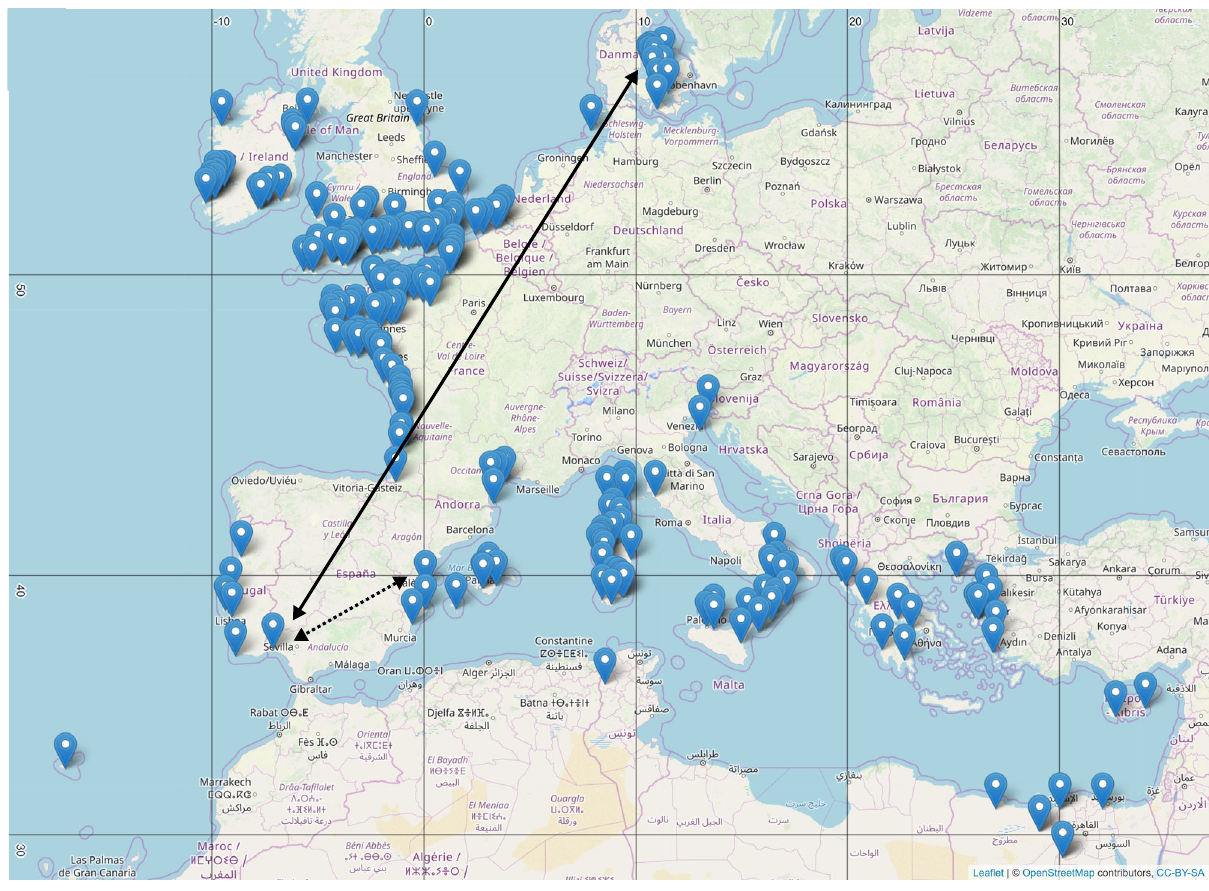
Fig. 4 Location of sequenced wild beet accessions based on sampling coordinates obtained from public passport data. The black arrow points to two accessions separated by large geographical distance that show a small genetic distance. The dotted arrow points to accessions both originating from Spain and showing a larger genetic distance. The accessions are highlighted in the tree in Supplementary Fig.